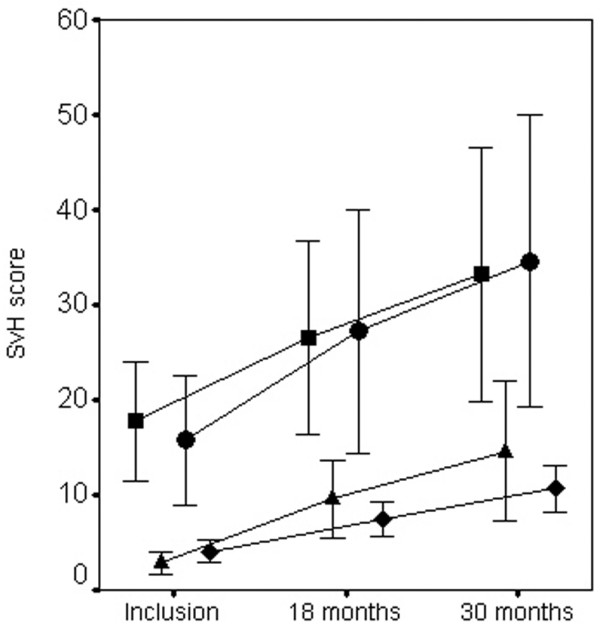
Total Sharp–van der Heijde (SvH) score at inclusion and at 18 and 30 months. Mean values and 95% confidence limits are illustrated. The four curves represent groups of patients at inclusion who had an erosion SvH score of at least 5 and positive anti-Sa (15, 14, and 14 patients at each visit) (squares), an erosion SvH score of at least 5 and negative anti-Sa (15, 13, and 13 patients at each visit) (circles), an erosion SvH score of 4 or less and positive anti-Sa (32, 30, and 30 patients at each visit) (triangles), and an erosion SvH score of 4 or less and negative anti-Sa (103, 97, and 92 patients at each visit) (diamonds).